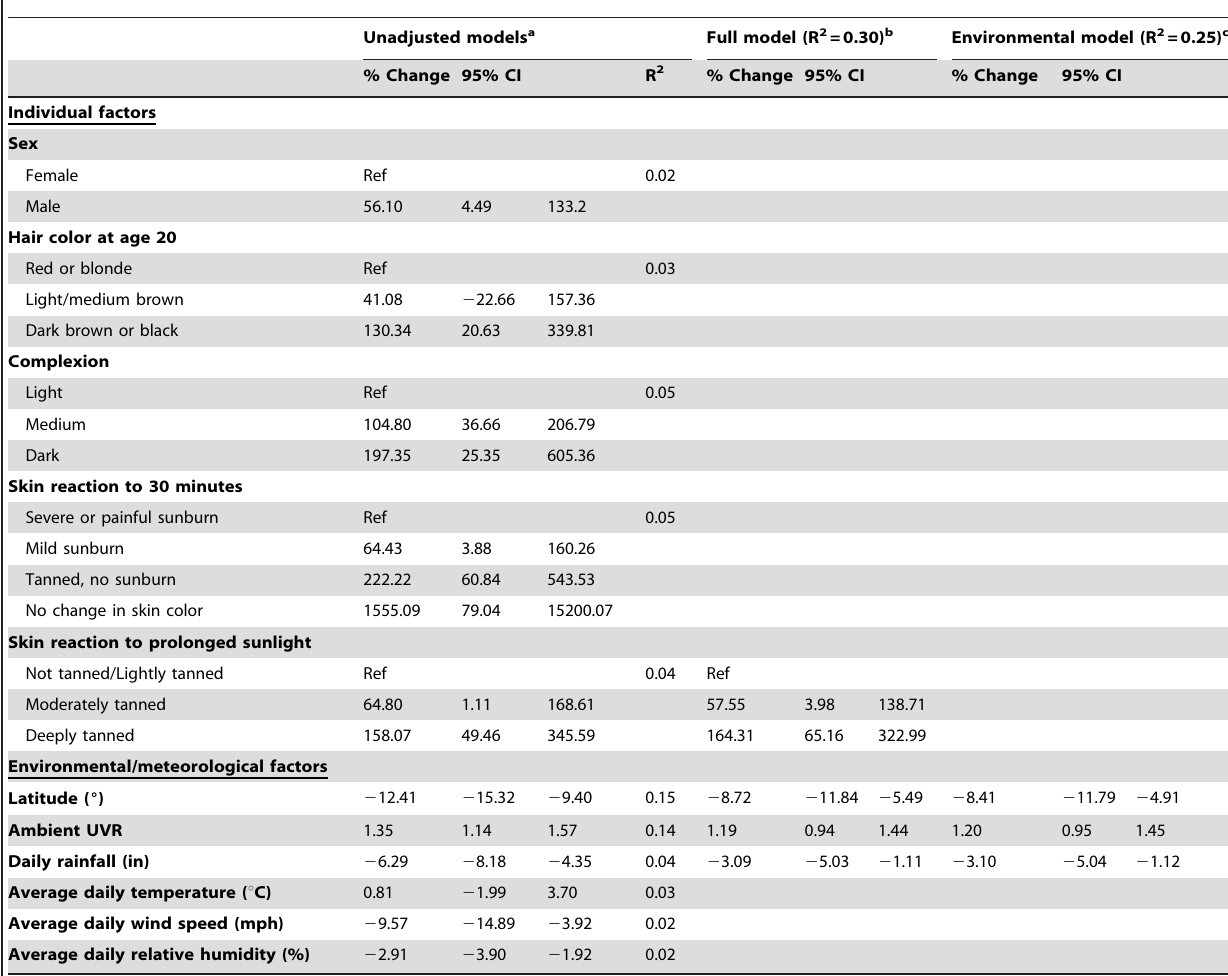
Table 2. Percent change in personal UVR exposure and 95% confidence